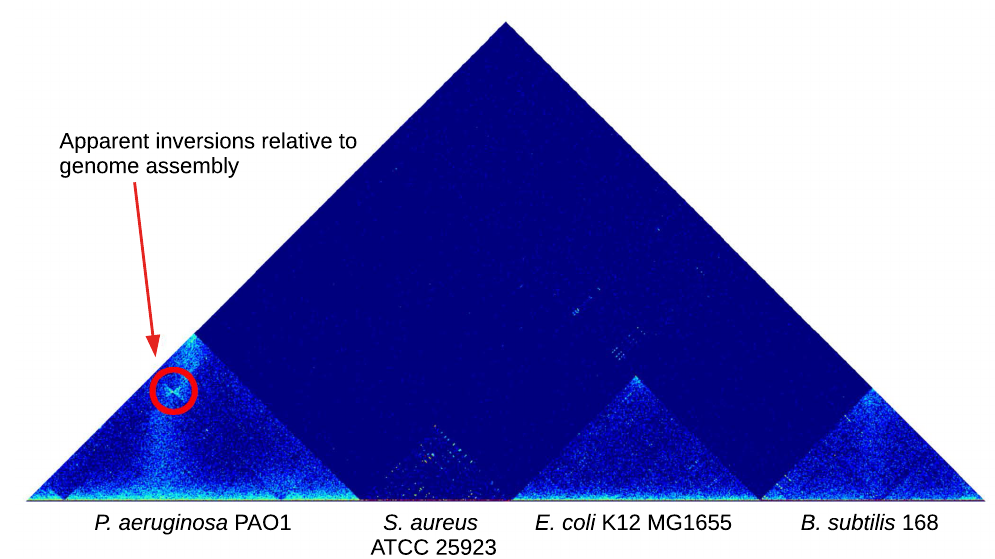
Figure 1. 3C/Hi-C heatmap. Contact map of chromatin interactions identified by metagenomic 3C. A synthetic community of four bacterial isolates was subjected to metagenomic 3C and the resulting read data mapped back to reference chromosome assemblies. Heat intensity is proportional to the number of read pairs associating the two chromosome regions. In P. aeruginosa and B. subtilis , the two arms of the circular chromosome are colocalized, as reflected in the column of intense heat emanating from the middle of their chromosomes. Erroneous cross-species associations are seen to be rare (deep blue